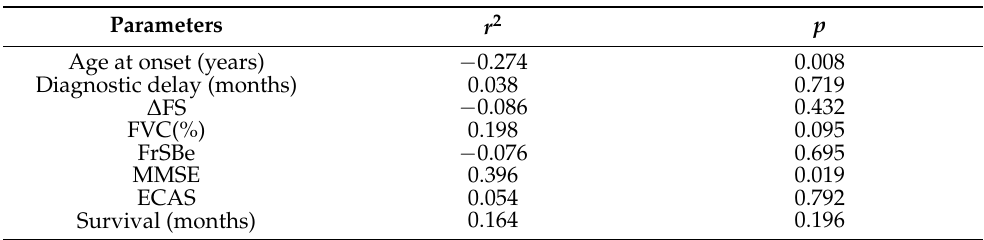
Table 4. Pearson’s correlation of the CSF A β 42/40 ratio with demographic, clinical and neuropsy- chological features of ALS